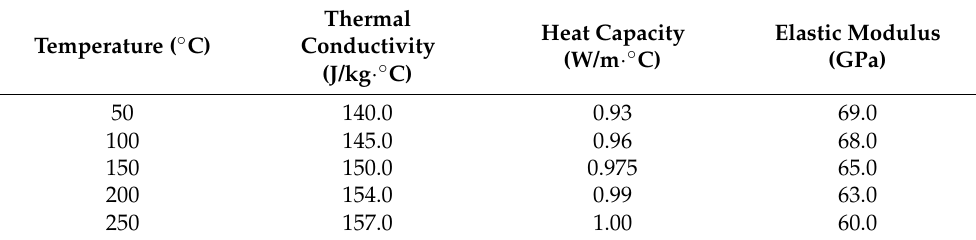
Table 3. Thermal and mechanical properties of Al-5754 aluminium alloy.